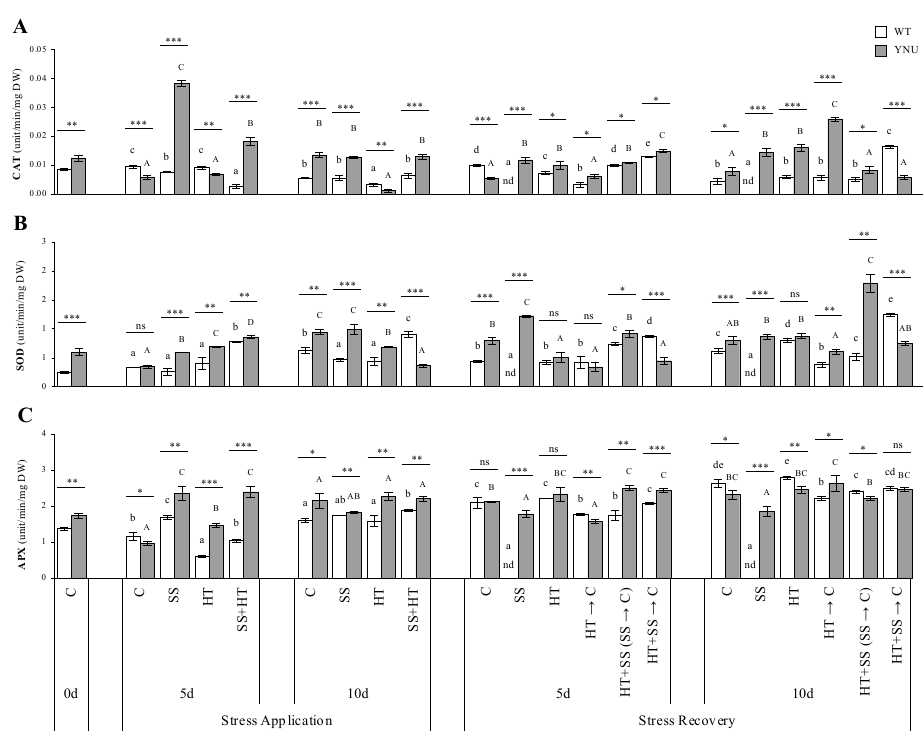
Figure 5. Antioxidant enzyme responses to salinity (SS), high-temperature (HT), and combined salinity and heat (SS + HT) of rice seedlings; ( A ) catalase (CAT), ( B ) superoxide dismutase (SOD), and ( C ) ascorbate peroxidase (APX) of WT and YNU plants under control (C: 26/23 °C, 0 mM NaCl), salt stress (SS: 26/23 °C, 75 mM NaCl), high-temperature (HT: 30/26 °C, 0 mM NaCl), and combined salinity and heat (SS + HT: 30/26 °C, 75 mM NaCl) conditions. Values represent the means ± SE determined from three independent experiments using four plants in each experiment. Means within the same graph followed by different lowercase (WT) and uppercase (YNU) letters are significantly different at p < 0.05 according to Tukey’s HSD test. Asterisks represent statistical significance of difference using Student’s t -statistic with *** p < 0.001, ** p < 0.01, * p < 0.05, ns: non-significant. nd: not determined.